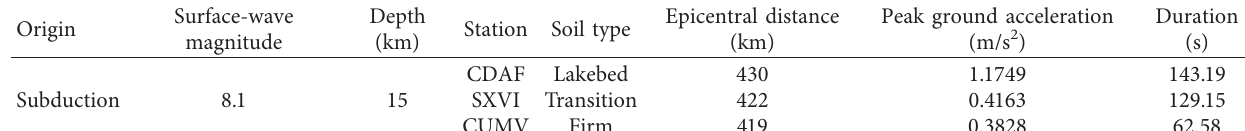
Table 13: General characteristics of the Mexico City earthquake of September 19, 1985.